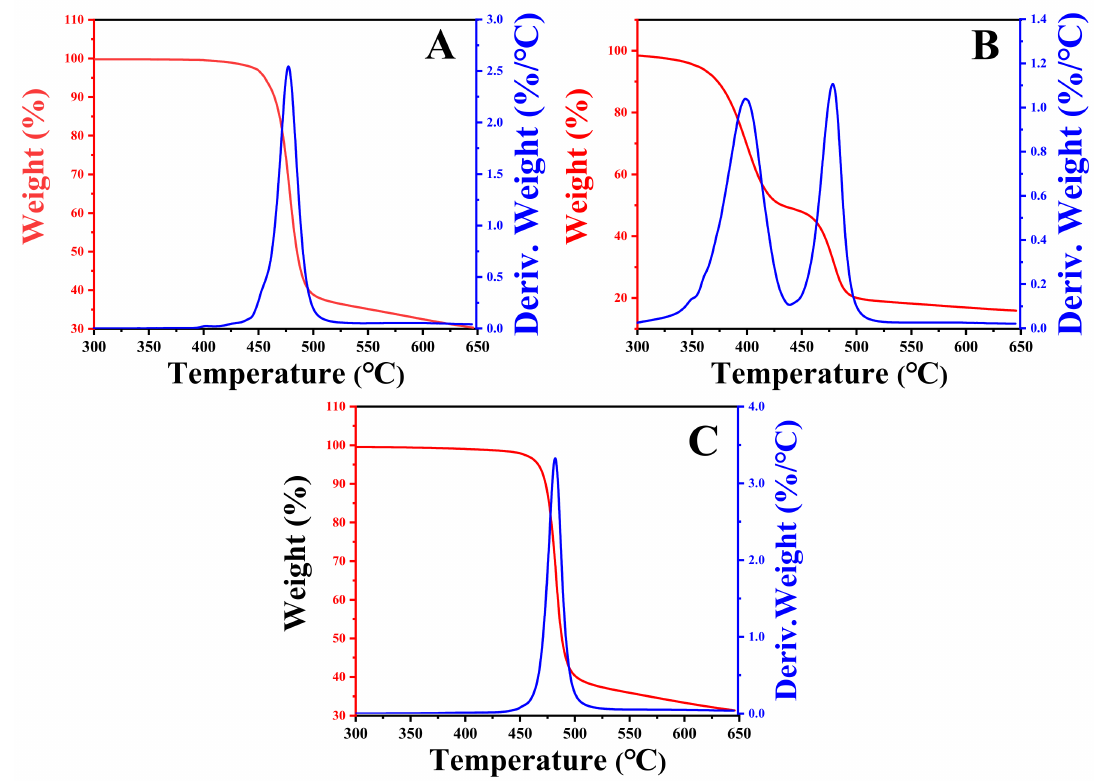
Figure 7. TGA curves of neat PVDF ( A ), PVDF/PMMA − 1 blend before ( B ), and after ( C ) chloroform etching.